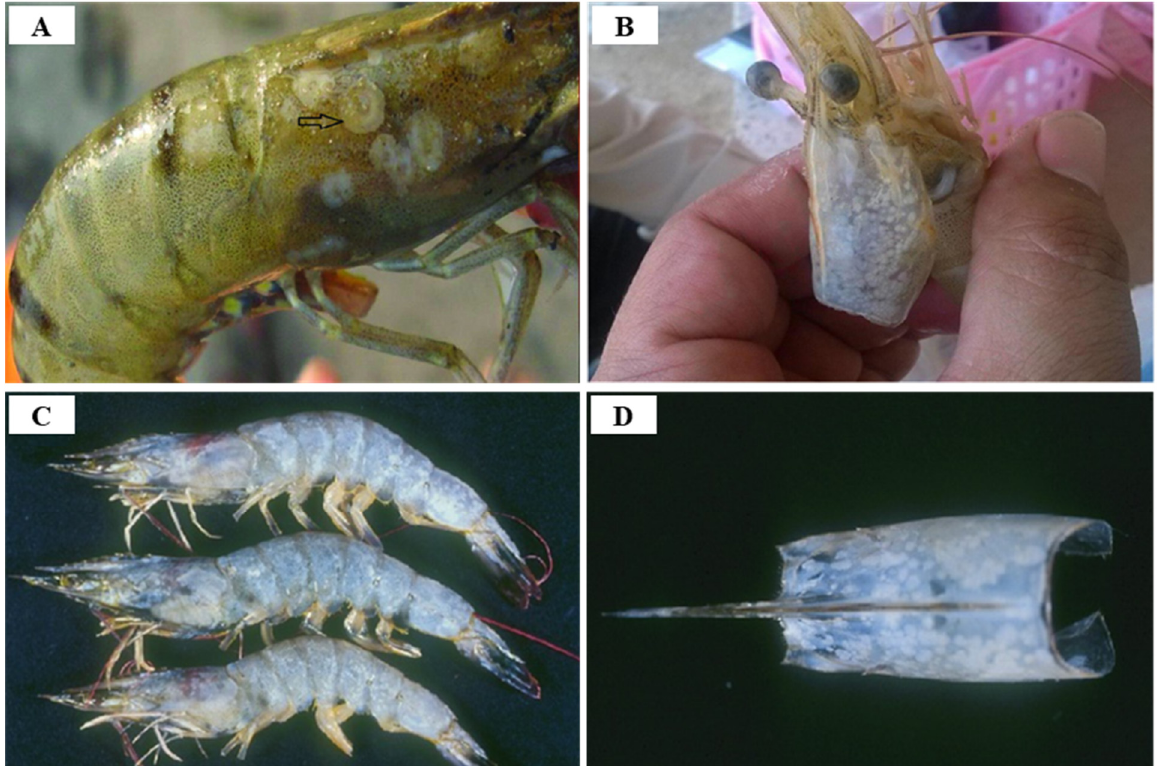
Figure 6. External white spot symptoms indicating white spot syndrome virus (WSSV)